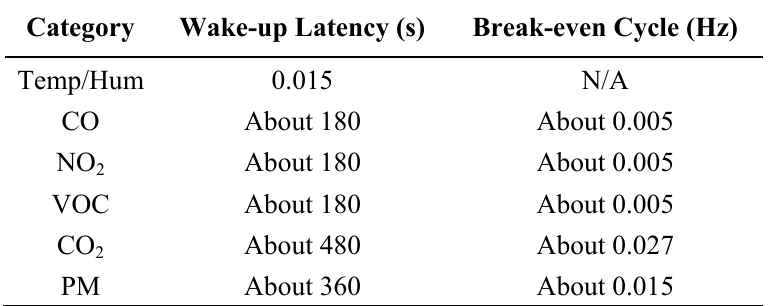
Table 3. Wake-up latency and break-even cycle of several